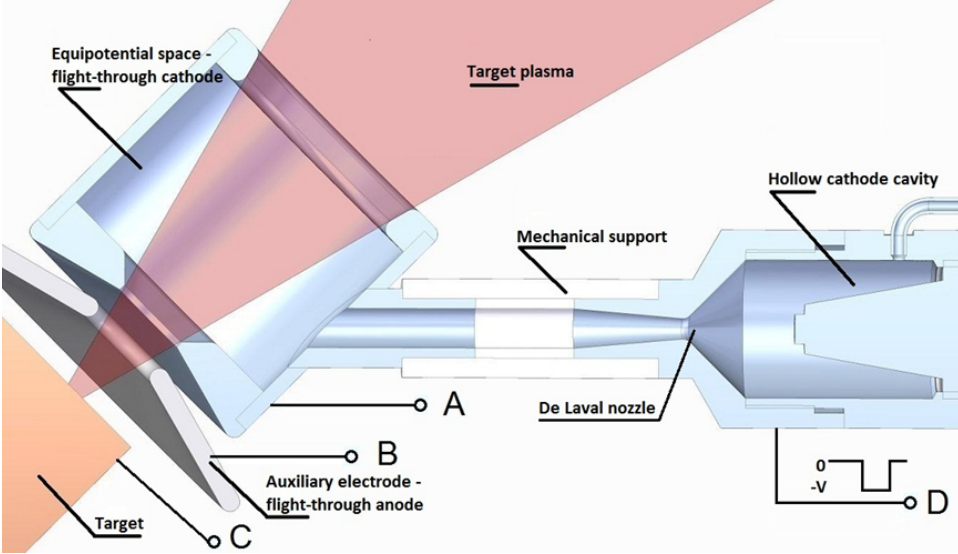
Figure 1. Example of an IJD source